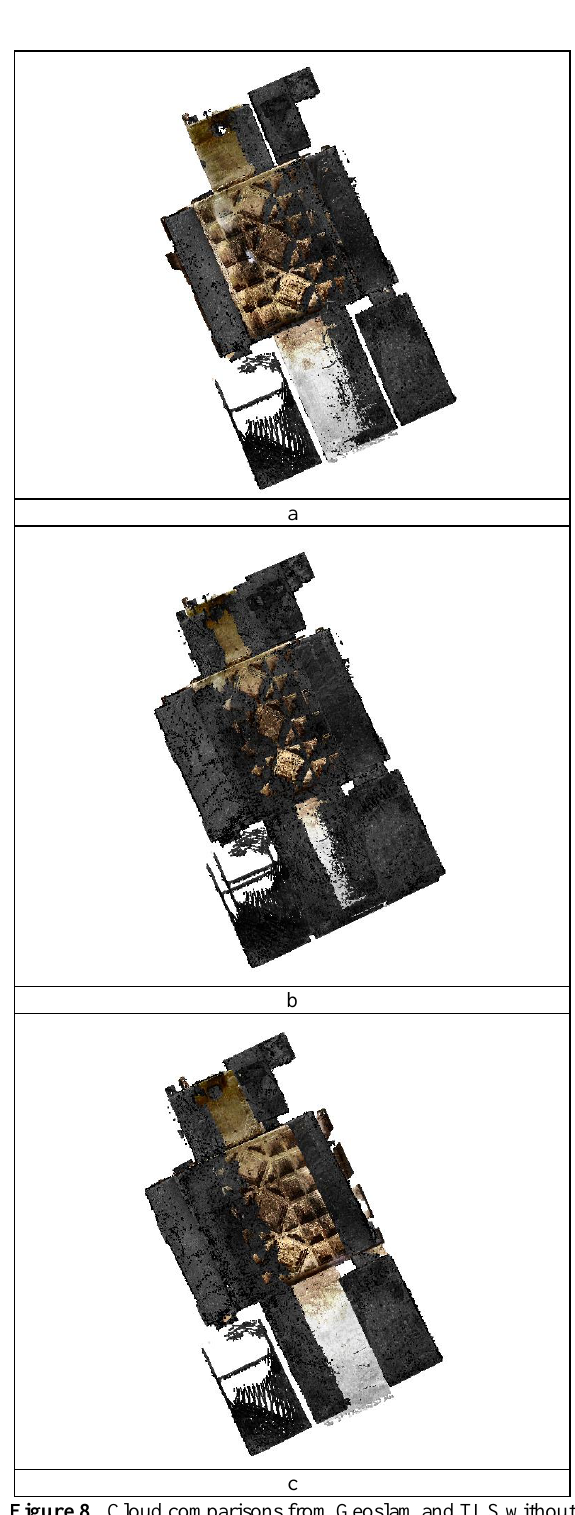
Figure 8 . Cloud comparisons from Geoslam and TLS without registration (a), with registration with rotation along the z axis only (b) and with registration with rotation along the three axes x,y,z The same registration was then tested with shifts in x,y,z and rotations in the three axes (fig.